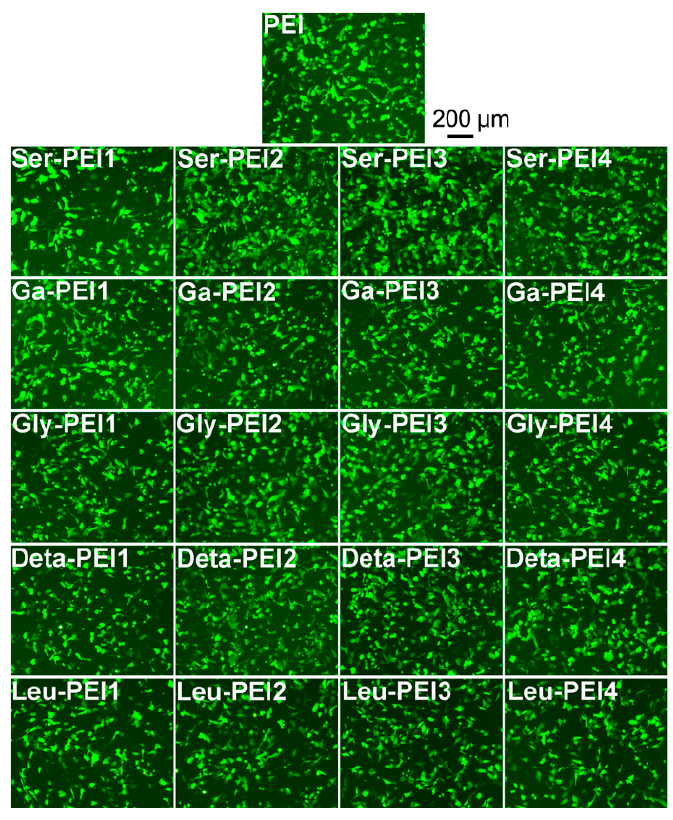
Figure 6. Fluorescence microscope images of pEGFP-transfected U-2OS cells by the polycations at their optimal weight ratio.